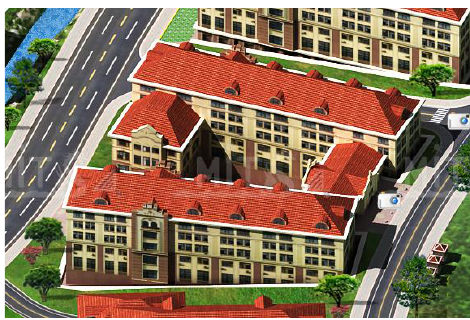
Figure 8. 3D model of the experimental site.